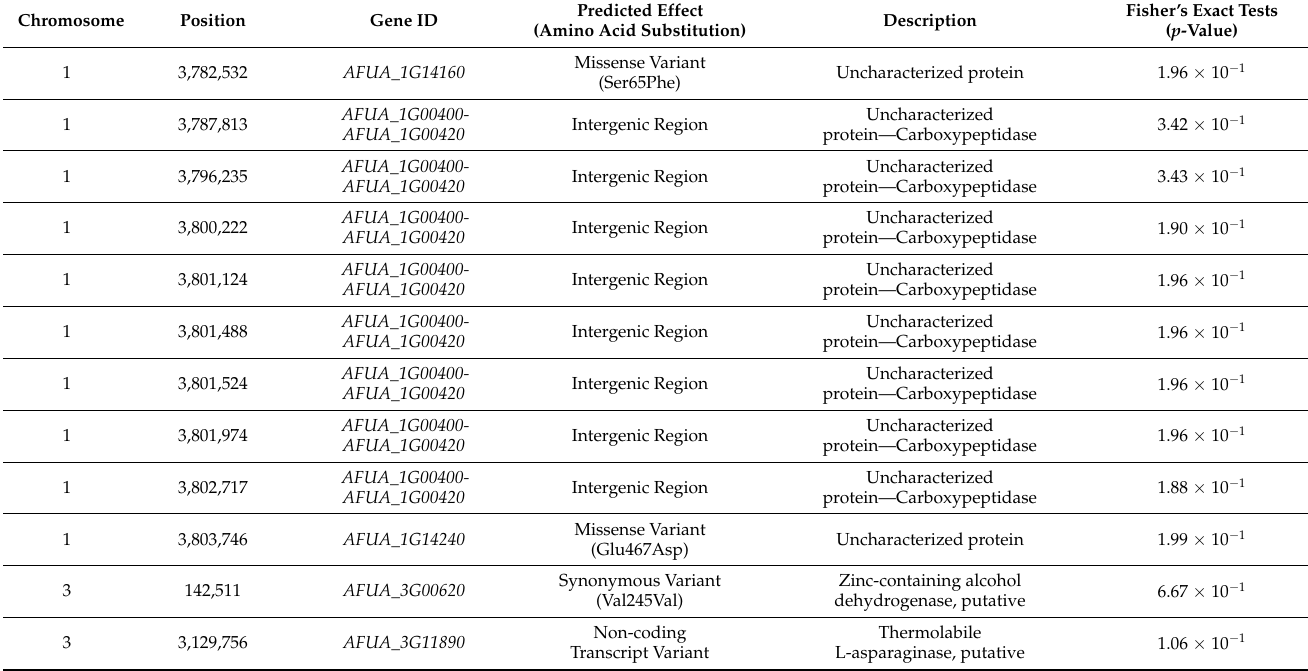
Table 3. Additional variants found through linkage disequilibrium analysis to be highly linked with the top 20 SNPs from the AMB GWAS. Fisher’s exact test p -values, comparing AMB-resistant and susceptible strains, are listed ( n =